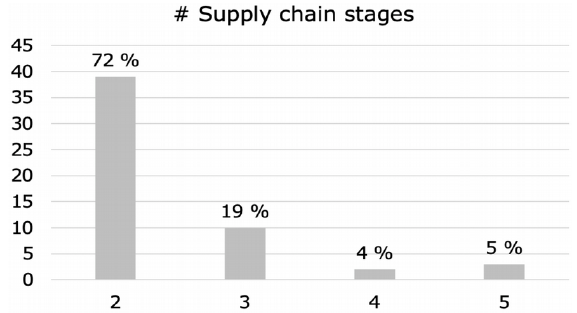
Figure 5. Statistics on supply chain structure: # Supply chain